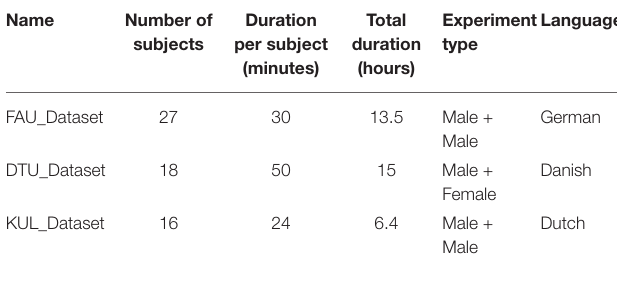
TABLE 1 | Details of the EEG datasets analyzed.